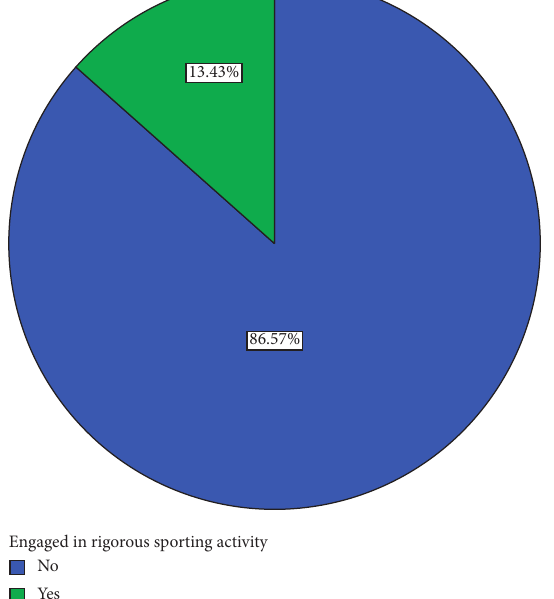
Figure 7: Distribution of whether or not participants engaged in rigorous sporting.